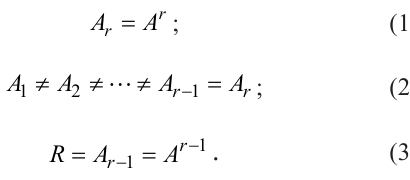
Table 4. Adjacency Matrix of critical success factors Factors ( i/j